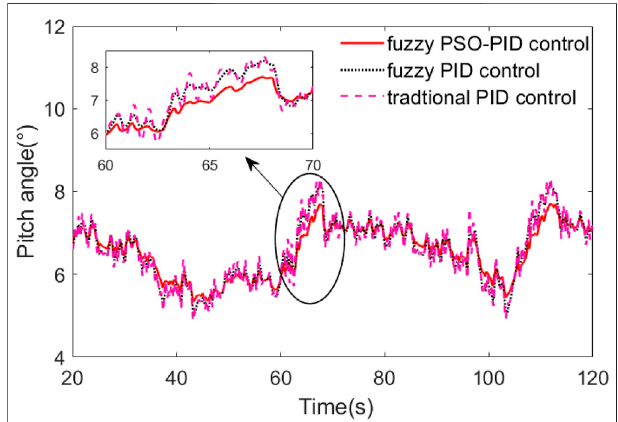
FIGURE 11 | Comparison curves of wind wheel speed under gust wind.